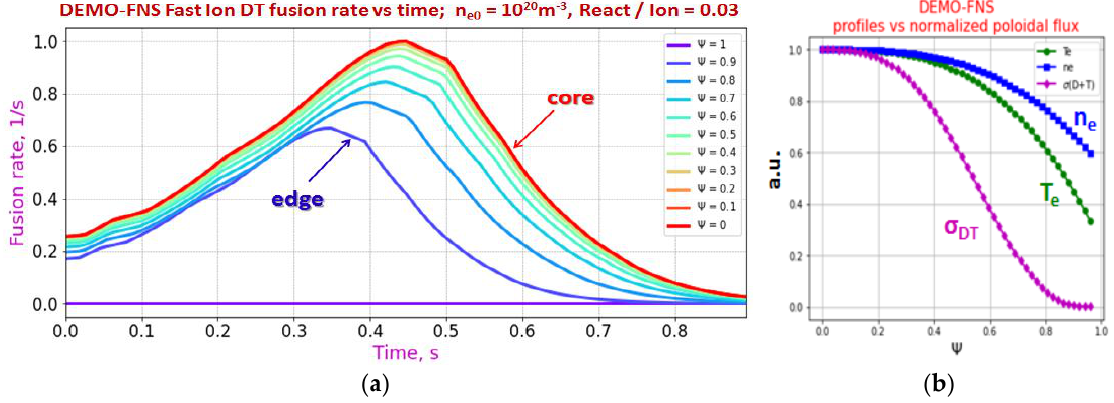
imum at plasma axis; the deuterium beam energy (equal to the fast ion start energy) is E b axis; the deuterium beam energy (equal to the fast ion start energy) is E b = 500 keV. The = 500 keV. The characteristic plasma profiles are shown in Figure 3b.